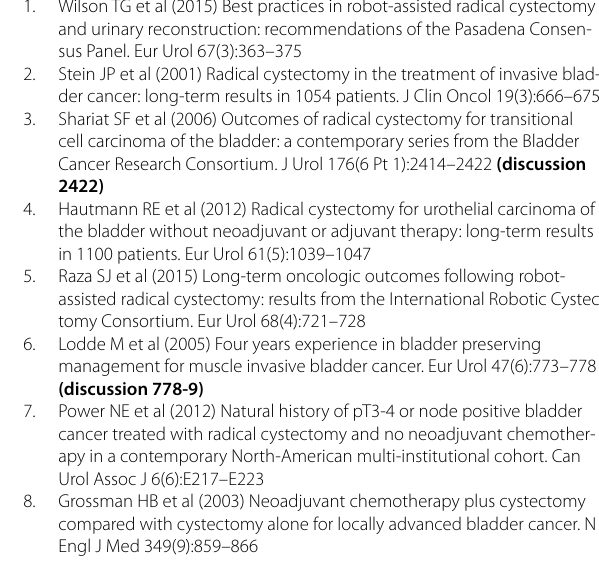
Additional file 2: Table S1 . Life tables for RFS, DSS and OS for LAD (high vs low QCS) vs OCD (high vs low QCS). Abbreviations RARC : Robot‑assisted radical cystectomy; RC: Radical cystectomy; LAD: Locally advanced disease; NAC: Neoadjuvant chemotherapy; LN: Lymph node; IRCC : International Robotic Cystectomy Consortium; OCD: Organ‑confined disease; BMI: Body mass index; ASA: American Society of Anesthesiologists; QCS: